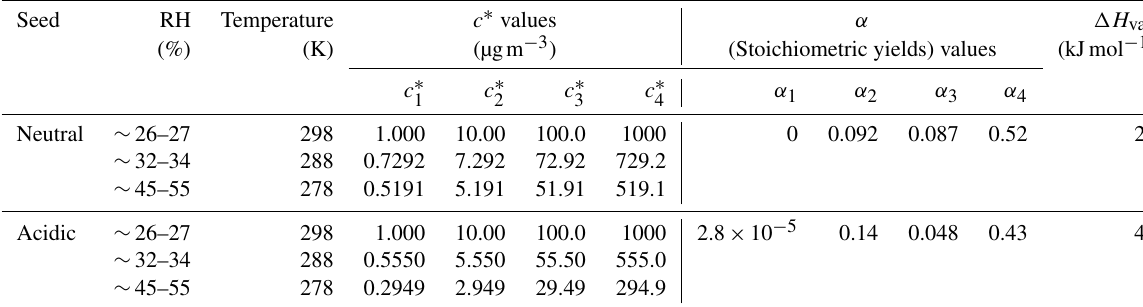
Figure 2. Yield comparison. SOA mass yields measured at 298K under neutral seed conditions in the present study were compared to those of previous studies. Colored markers represent the results of this study. Colored circular markers represent the real-time SOA yields, i.e., the SOA yields along with the α -pinene ozonolysis reactions from 0 to 90min. Different experimental runs are differentiated by colors. Red solid square markers represent the final SOA yields of the seven experiments. Horizontal error bars indicate the uncertainties of the final SOA concentrations; vertical error bars indicate the uncertainties of the final SOA yields. However, the systematic errors from vapor wall loss are not included. The open square indicates the result of exp. no. 2 after gas-phase wall-loss correction (Text S5). Black markers and curves represent results of previous studies. Black markers represent experimental results. The solid and dotted black curves represent the parameterized results from the four-product volatility basis-set fittings of previous α -pinene ozonolysis experiments under low-NO x and dark conditions summarized in Pathak et al. (2007a). The solid curve represents results under a 50%–73% RH range, and the dotted curve represents results under RH < 10%. The dashed curve represents the results calculated using Eqs. (1), (6), (7), (10), and (11) at 303K in Saathoff et al., 2009. The experiments of Saathoff et al. (2009) were carried out at 303K and 48%–37% and 0.02% RH, without or with OH scavenger (cyclohexane or 2-butanol); experiments of Wang et al. (2011) were carried out at 295K and < 1% RH, without OH scavenger; experiments of Wang et al. (2014) were carried out at 295K and < 5% RH, without OH scavenger; experiments of Nah et al. (2016) were carried out at 298K and < 5% RH, with cyclohexane as OH scavenger; experiments of Ye et al. (2018) were carried out at 296K and 12%– 14% and 48%–49% RH, with cyclohexane as OH scavenger; experiments of Kenseth et al. (2020) were carried out at 295K and < 5% RH, without OH scavenger; and experiments of Czoschke and Jang (2006) were carried out at 294–300K and 14%–67% RH, without OH scavenger. Note that all data presented in this figure are normalized to unity density (1gcm − 3 ). Table 1. Four-product VBS model fitting